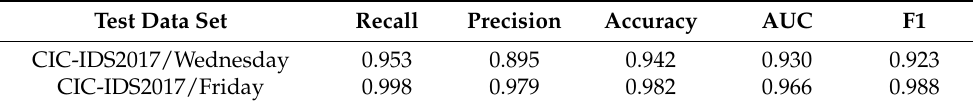
Table 5. Performance of the BI-LSTM-GMM with incremental learning.